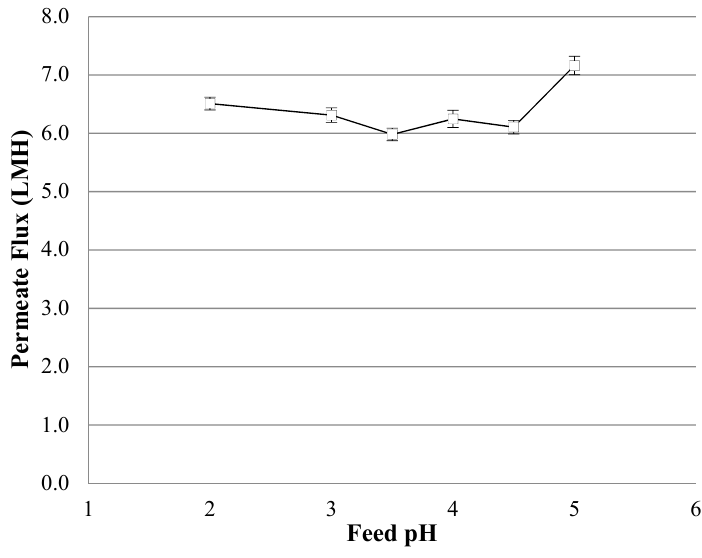
Figure 9. AMD permeate flux as a function of feed pH.